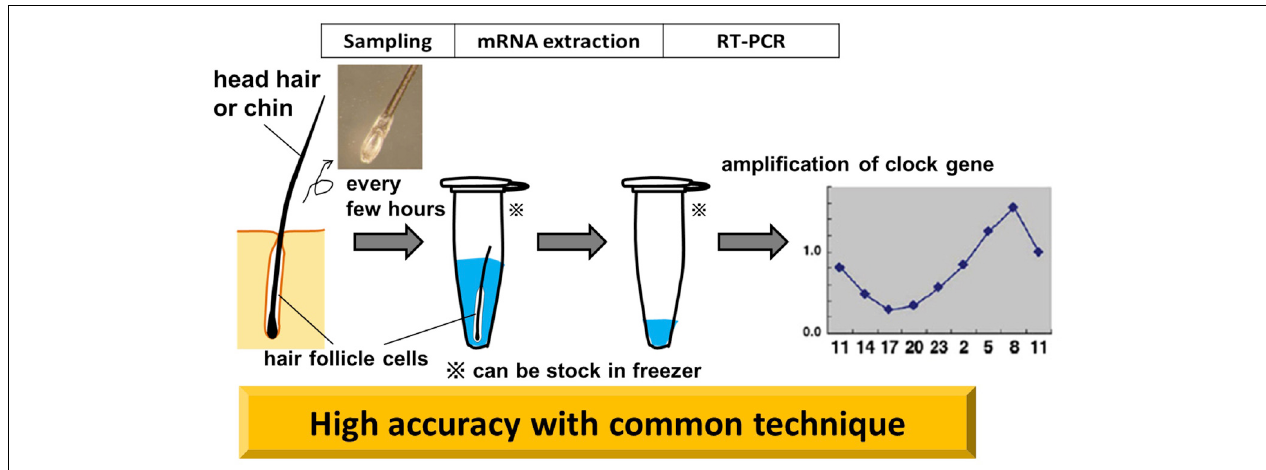
FIGURE 5 | Non-invasive circadian clock detection with hair follicle cells. Overview from sampling to quantification by realtime-PCR (RT-PCR). Plucking head hair sharply at the roots with non-slip tweezers in the direction of hair